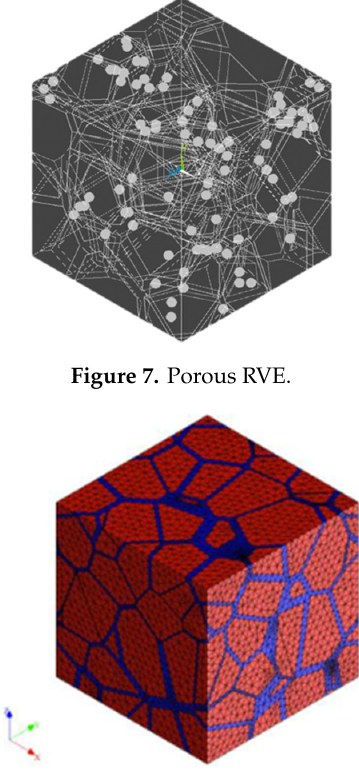
Figure 8. Meshed RVE. Figure 8. Meshed